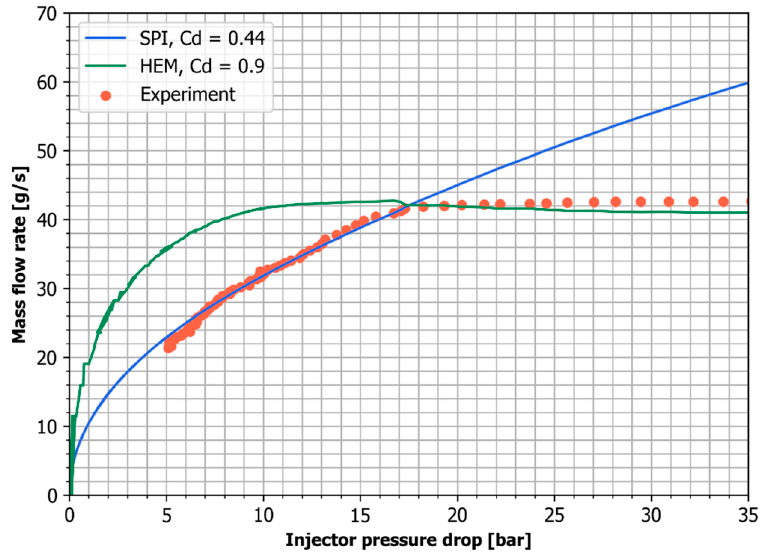
Figure 8. Mass flow rate versus injector pressure drop ∆ P for the Injector No. 2. SPI and HEM curves have been plotted using pressure data from the test.